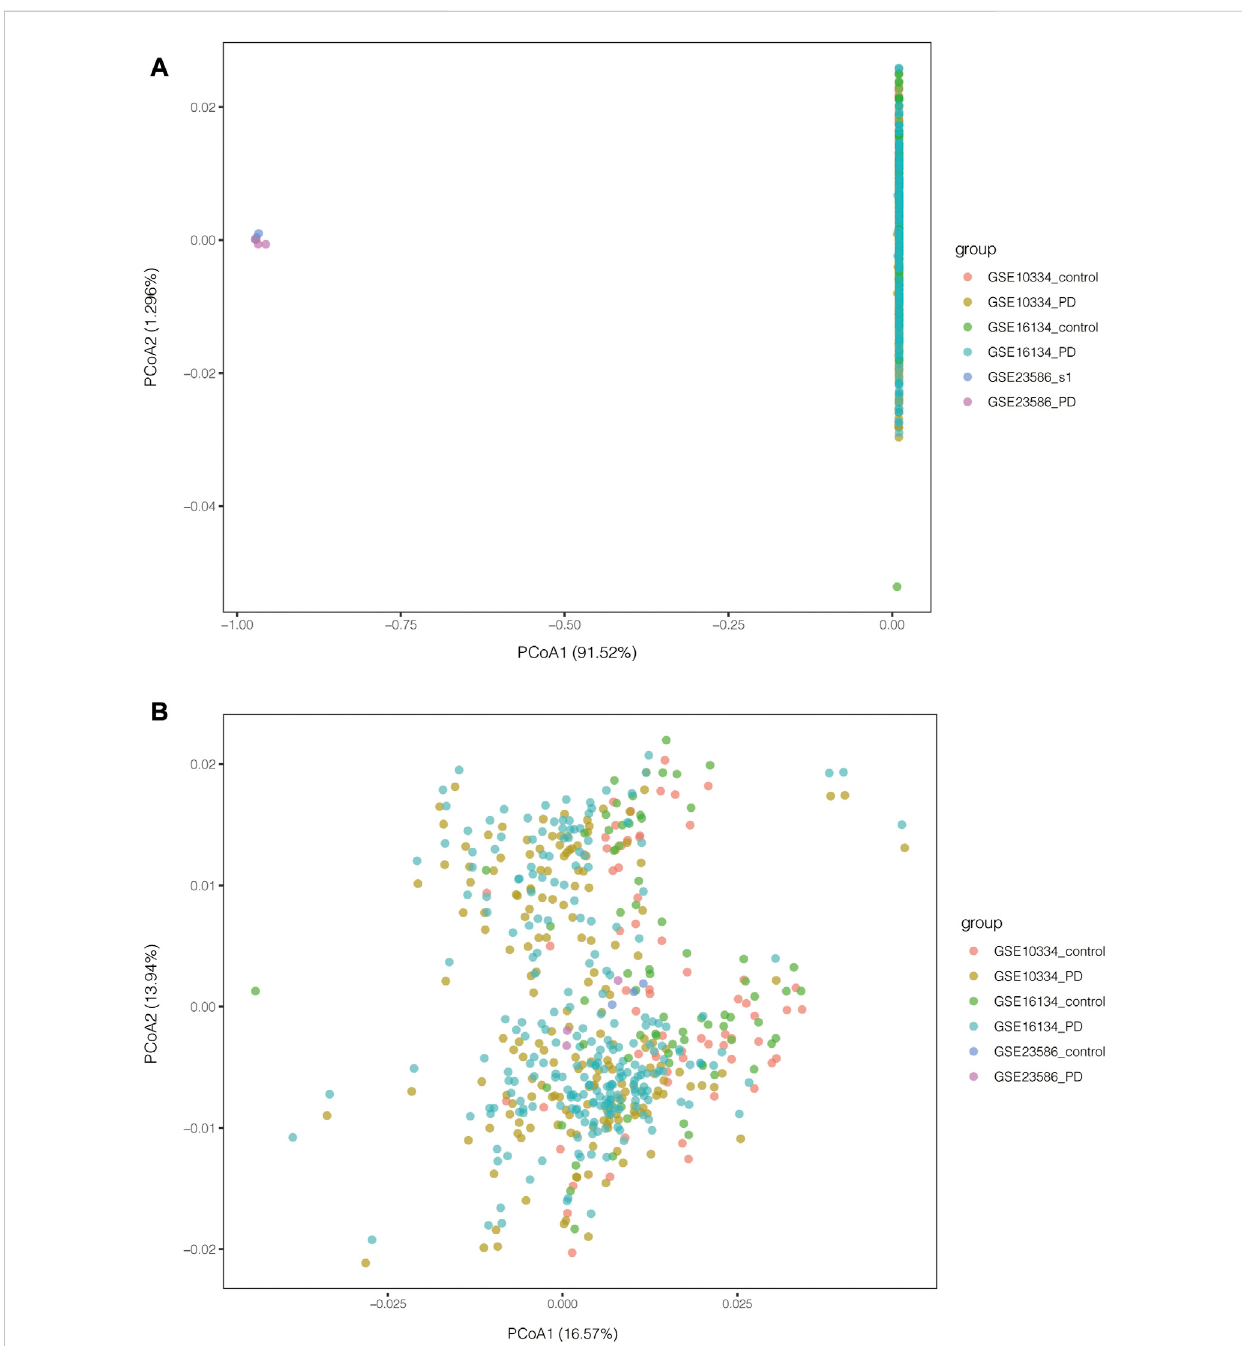
FIGURE 2 PCAresultsofPD-relateddatasetsbeforeand afterbatchcorrection. (A) PCAresultsbeforebatchcorrection; (B) PCAresults afterbatchcorrection.